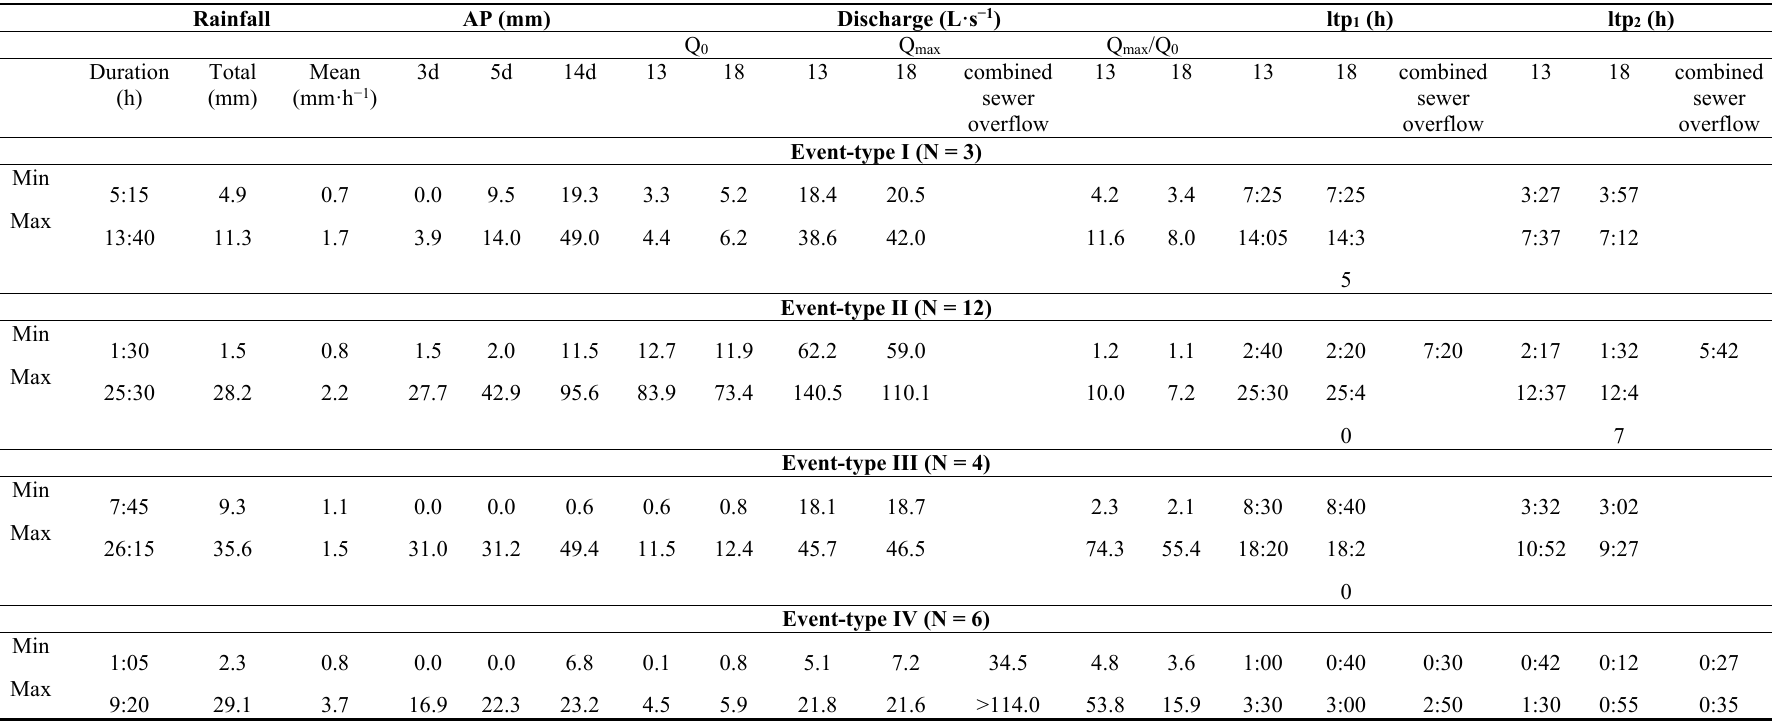
Table 3. Summary statistics for ltp-analyses of rainfall-induced runoff